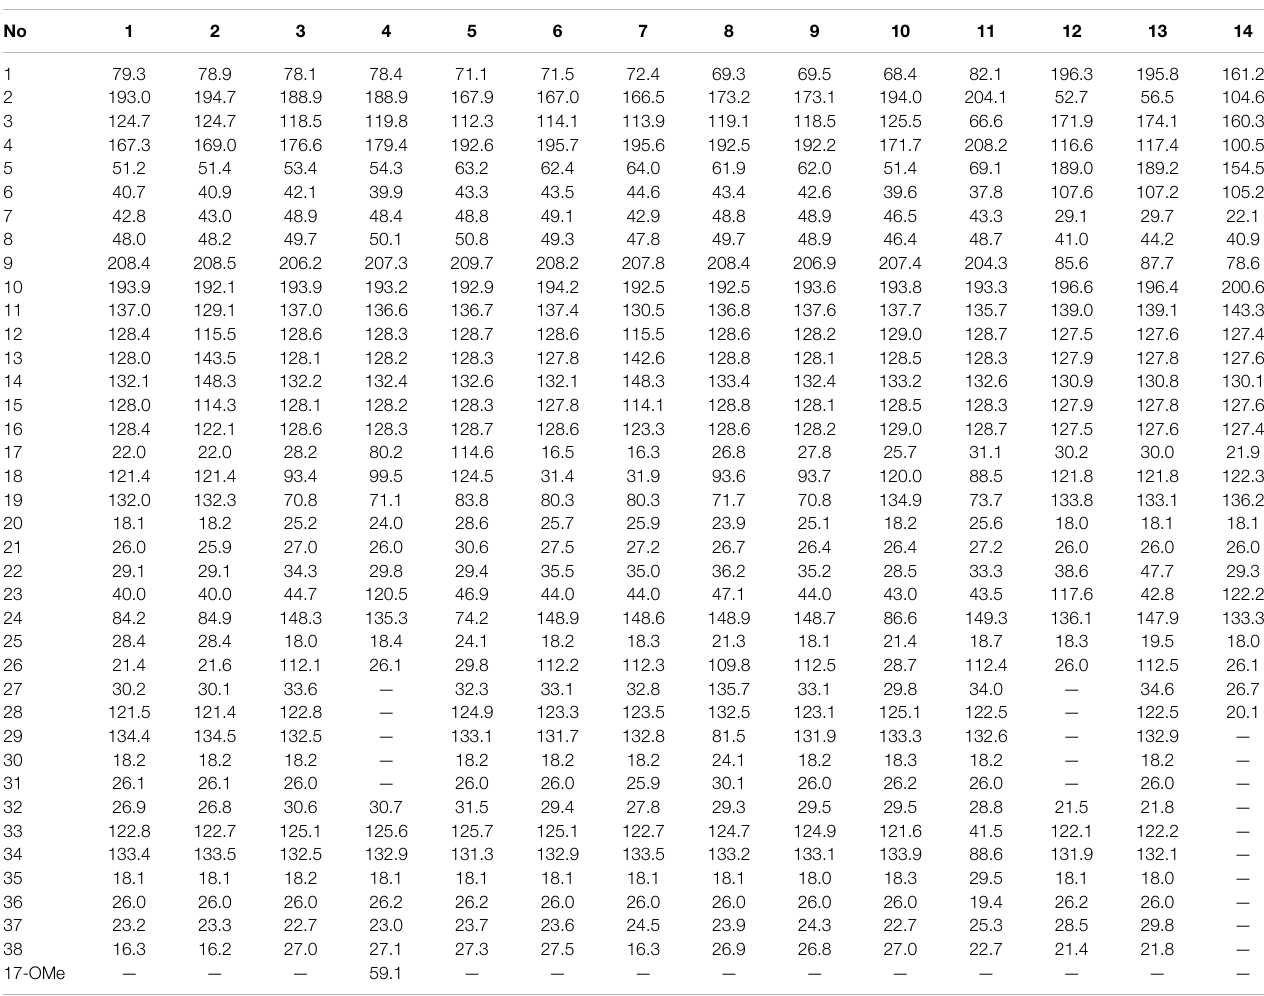
TABLE 1 | 13 C NMR data of compounds 1 – 14 in CDCl 3 (150 MHz, δ in